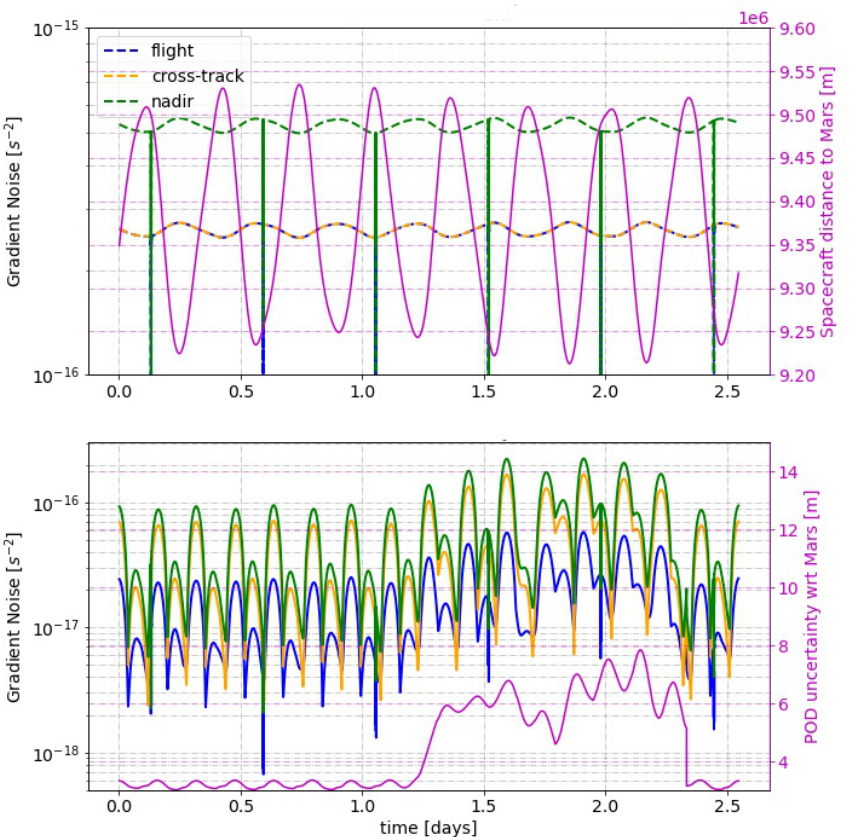
Figure A1. Top : gradient noise from Mars gravity field uncertainty. A single orbit is representative of the entire front since all orbits are similar in the Mars-fixed frame. Bottom : gradient noise from spacecraft state uncertainty, for the worst-case orbit. Note that the arc length is 2.2 days, and tracking ends after 1.1 days (50% capacity) hence the uncertainty is highest after this